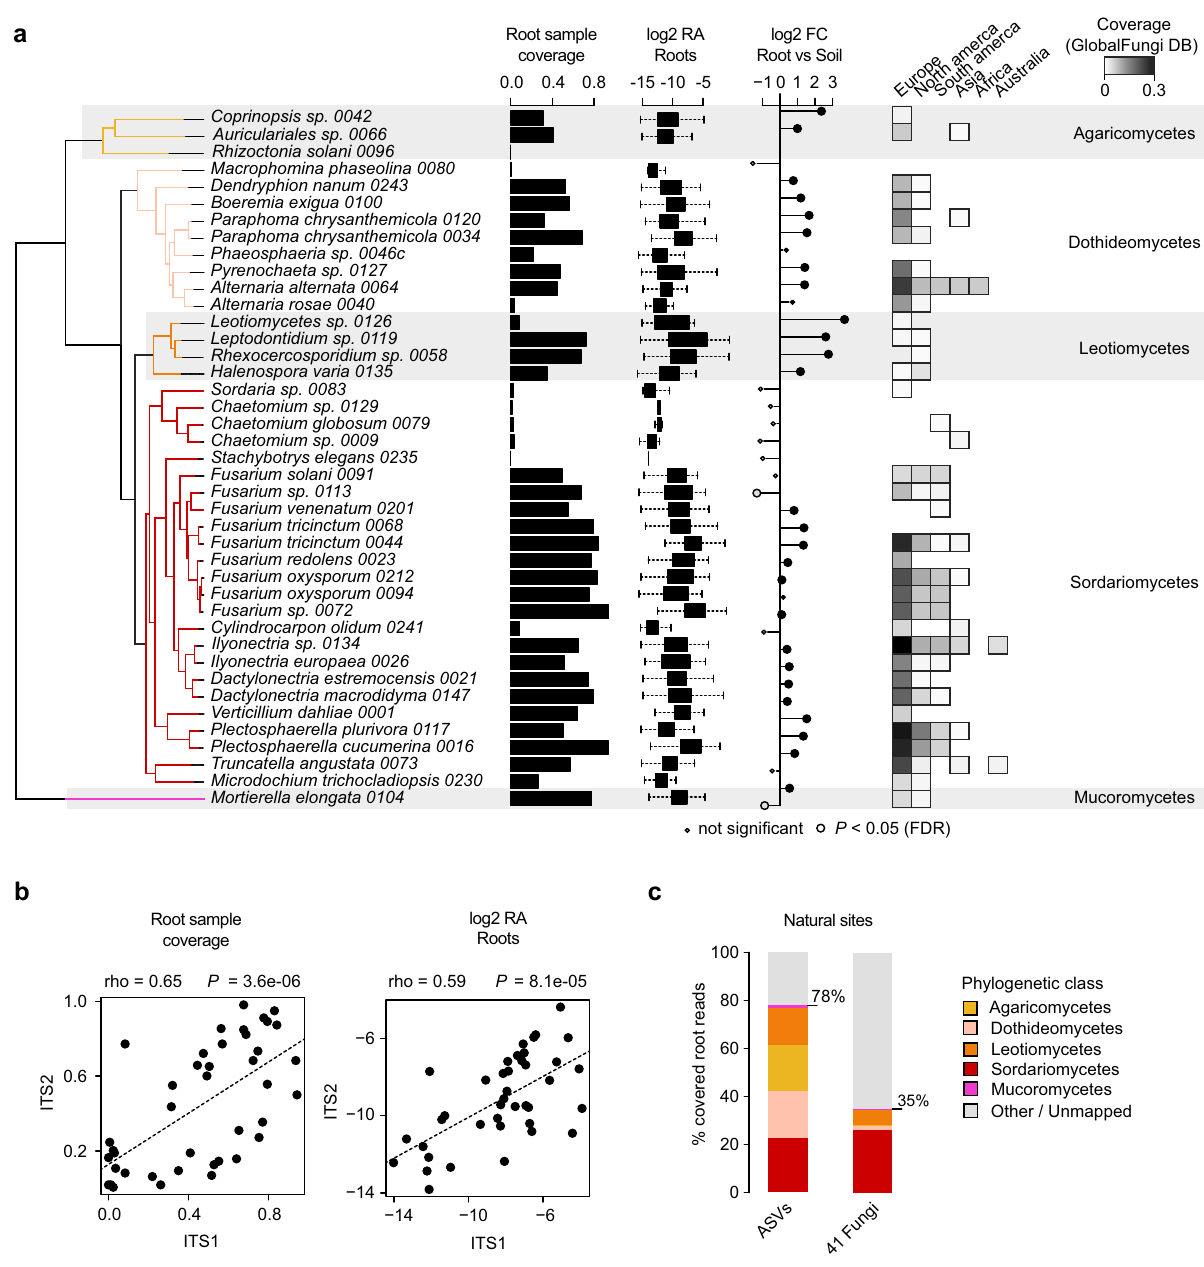
Fig. 1 Prevalence and abundance pro fi les of 41 root-colonizing fungi across naturally occurring A. thaliana root mycobiomes. a Species names and phylogenetic relationships among the 41 selected fungi. Estimated prevalence (i.e., root sample coverage, bar-plots), relative abundance (RA, log2 transformed, box-plots), and enrichment signatures (log2FC, circles) were calculated for each fungus based on data from a previously published continental-scale survey of the A. thaliana root mycobiota 18 . ITS1 tags from natural site samples were directly mapped against the reference ITS1 sequences of the selected fungi. Sample coverage in roots was computed based on n = 169 root samples and estimated RA were calculated for root samples having a positive hit only. On the RA boxplot, boxes are delimited by fi rst and third quartiles and whiskers extend to show the rest of the distribution. Log 2 Fold- Change (log2FC) in RA between root ( n = 169) and soil samples ( n = 223) is shown based on the mean RA measured across samples and signi fi cant differences are indicated by circle sizes (two-sided Mann – Whitney U test, FDR < 0.05, see detailed values in Supplementary Data 1). ITS1 sequence coverage measured across 3 582 root samples retrieved from the GlobalFungi database 38 . Note that samples were analyzed separately by continent. b Correlation between root sample coverage (left panel) measured in ITS1 ( n = 169) and ITS2 ( n = 158) datasets for each of the 41 fungi ( n = 41, Spearman ’ s rank correlation). Right panel: same correlation but based on log2 RA values ( n = 41, Spearman ’ s rank correlation). c RA pro fi les of naturally occurring fungi (class level) detected in A. thaliana roots across 17 European sites 18 ( “ all ASVs ” , left) and the corresponding distribution of the ITS1 sequences of the 41 selected fungi ( “ 41 fungi ” , right). Note that the cumulative RA of the 41 fungi accounts for 35% of all sequencing reads detected in A. thaliana roots across European